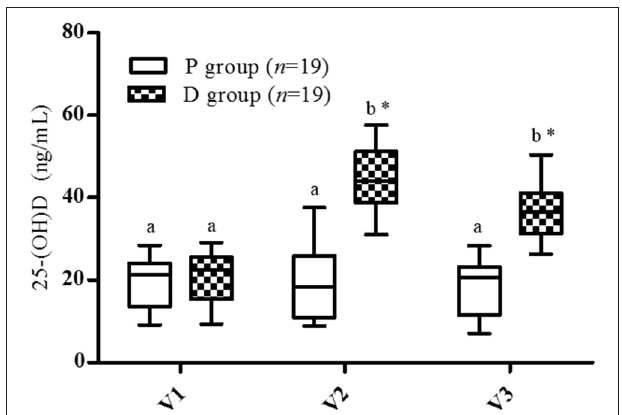
FIGURE 2 | Vitamin D serum levels. V1, inclusion; V2, end of supplementation and vaccination; V3, 28 days post-vaccination. Data are expressed as mean ± SD. Statistical analysis was performed by two-way ANOVA for the supplementation and time effect followed by Bonferroni post hoc test ( p < 0.05); *Significantly different between groups at the same visit ( p < 0.05); a,b Significantly different between visits in the same group ( p < 0.05).